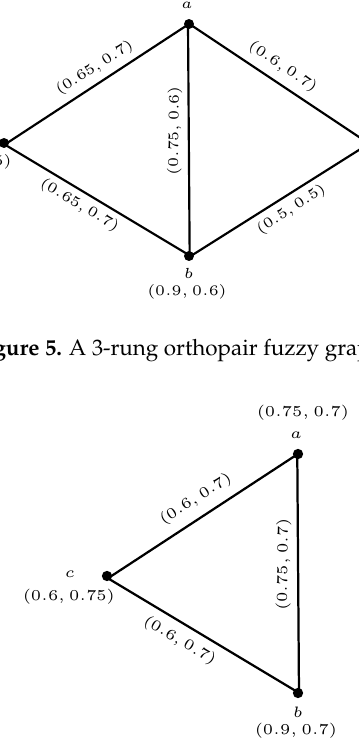
Figure 3.3: A 3-rung orthopair fuzzy graph G